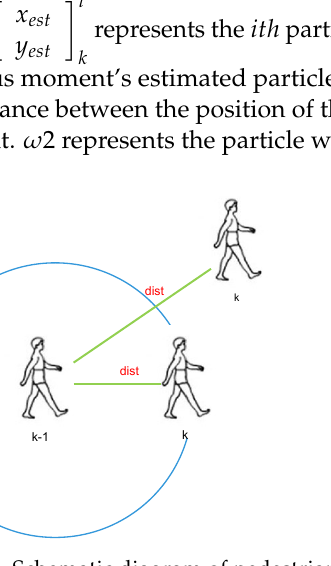
Figure 5. Schematic diagram of pedestrian walking